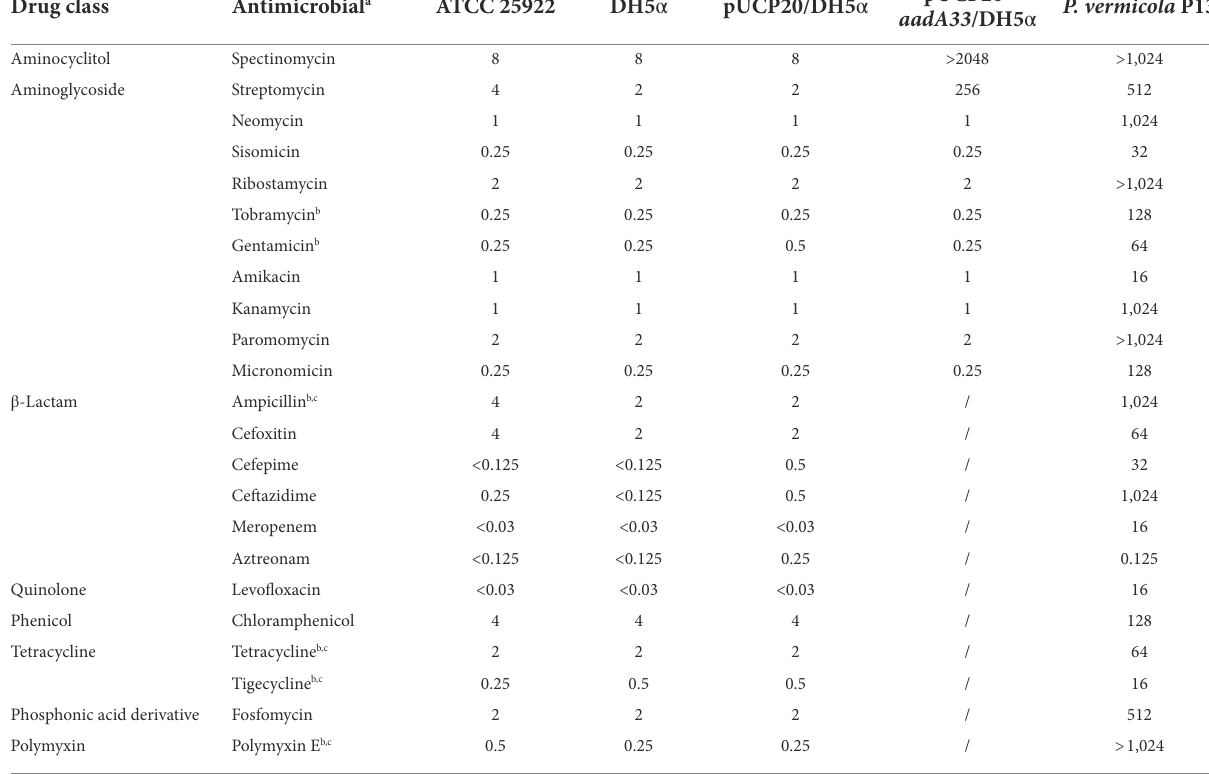
TABLE 2 MICs of 23 antimicrobials for 5 strains ( μ g/ml).